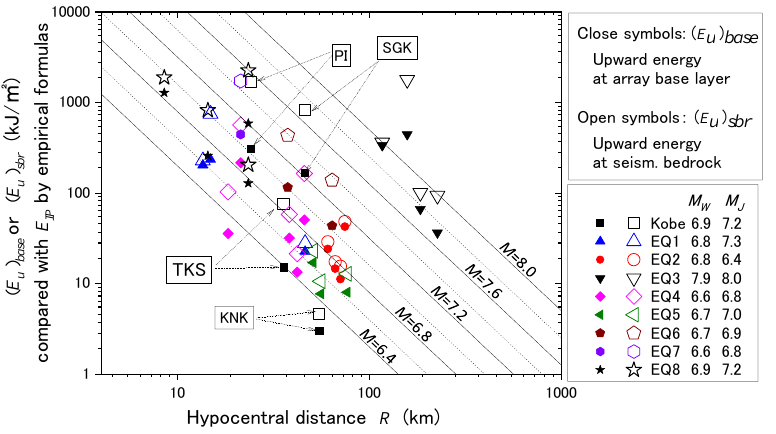
Figure 15. Upward energies at array base ( E u ) base or seismological bedrock ( E u ) sbr versus hypocenter distance R , compared with incident energies E IP versus R lines by empirical formulas. Based on the finding that Equation (26) may be conveniently used to roughly evalu- ate the energy ratio between arbitrary two layers, the same equation was further used here to estimate the upward energies at the seismological bedrock ( E u ) sbr from those at the base layer ( E u ) base of the individual vertical arrays. It may well be justified here that major wave energy is still carried by vertically propagating SH wave, even in stiff rocks, down to the seismological bedrock despite potentially increasing involvement of SV waves. The im- pedance for the seismological bedrock is postulated here as V s = 3000 m/s and = 2.7